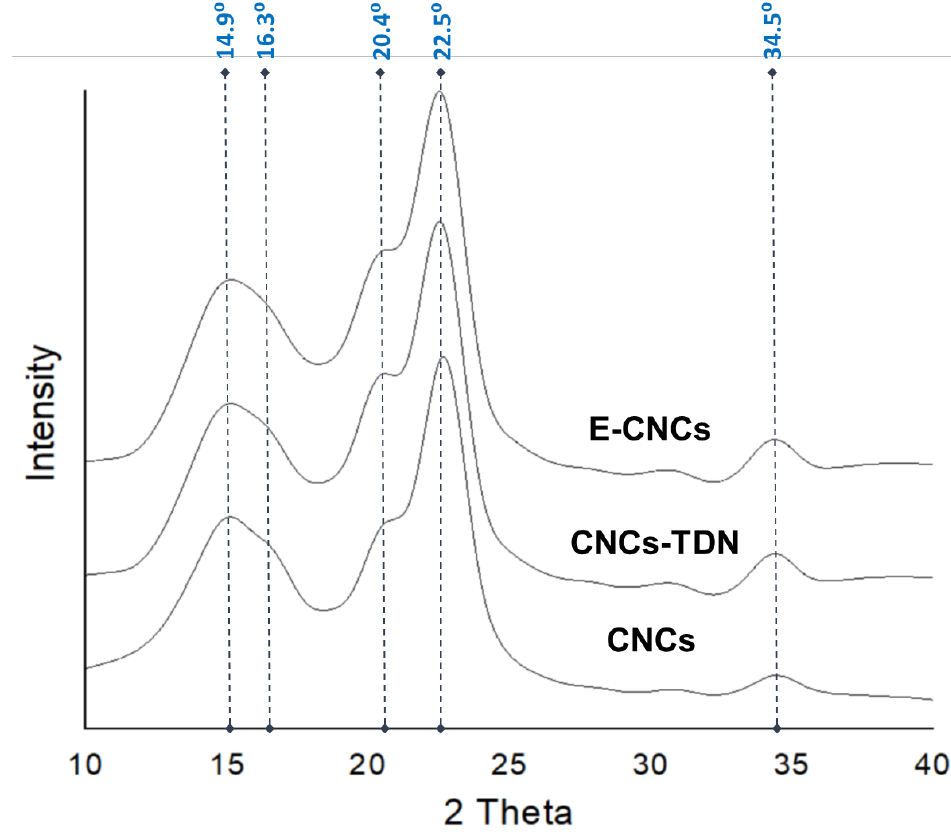
Figure 6. The crystalline structure of the original CNCs after hydrolysis using HCl-acidified DMSO (CNCs-TDN) and after polymerization using APS (E-CNCs).